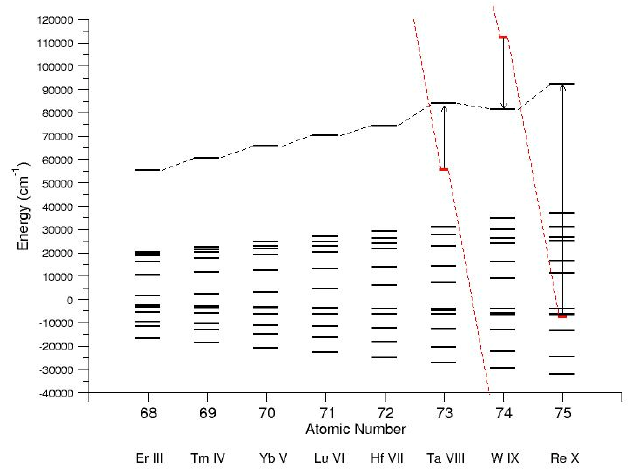
Figure 8. Isoelectronic comparison of the energy levels belonging to the 4f 12 5s 2 5p 6 configuration from Er III to Re IX (black bars). Black dashed lines trace the highest J = 0 level. Red dashed lines show the trend of changes for the two perturbing J = 0 levels of 4f 14 5s 2 5p 4 . Only one J = 0 perturber could be represented (short red bars) on the chosen scale. Their perturbation effects are indicated by vertical